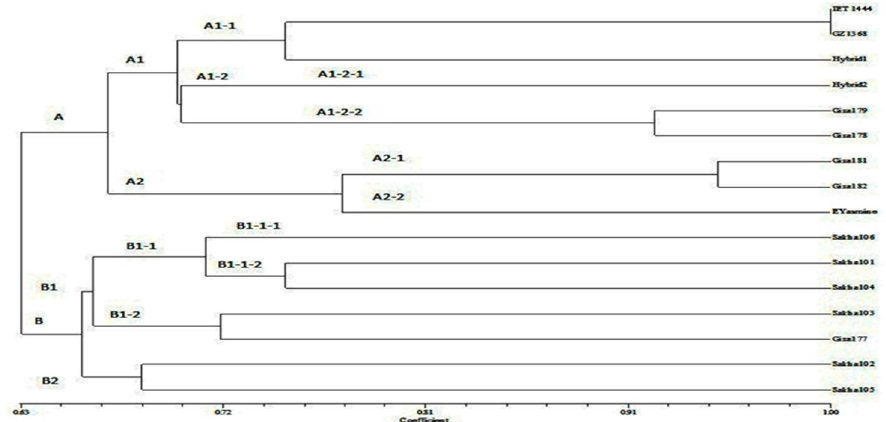
Figure 2. Dendrogram derived from unweighted pair group method with arithmetic averages (UPGMA) cluster analysis of sixteen rice genotypes based on Jaccard’s similarity coefficient using 10 SSR markers.